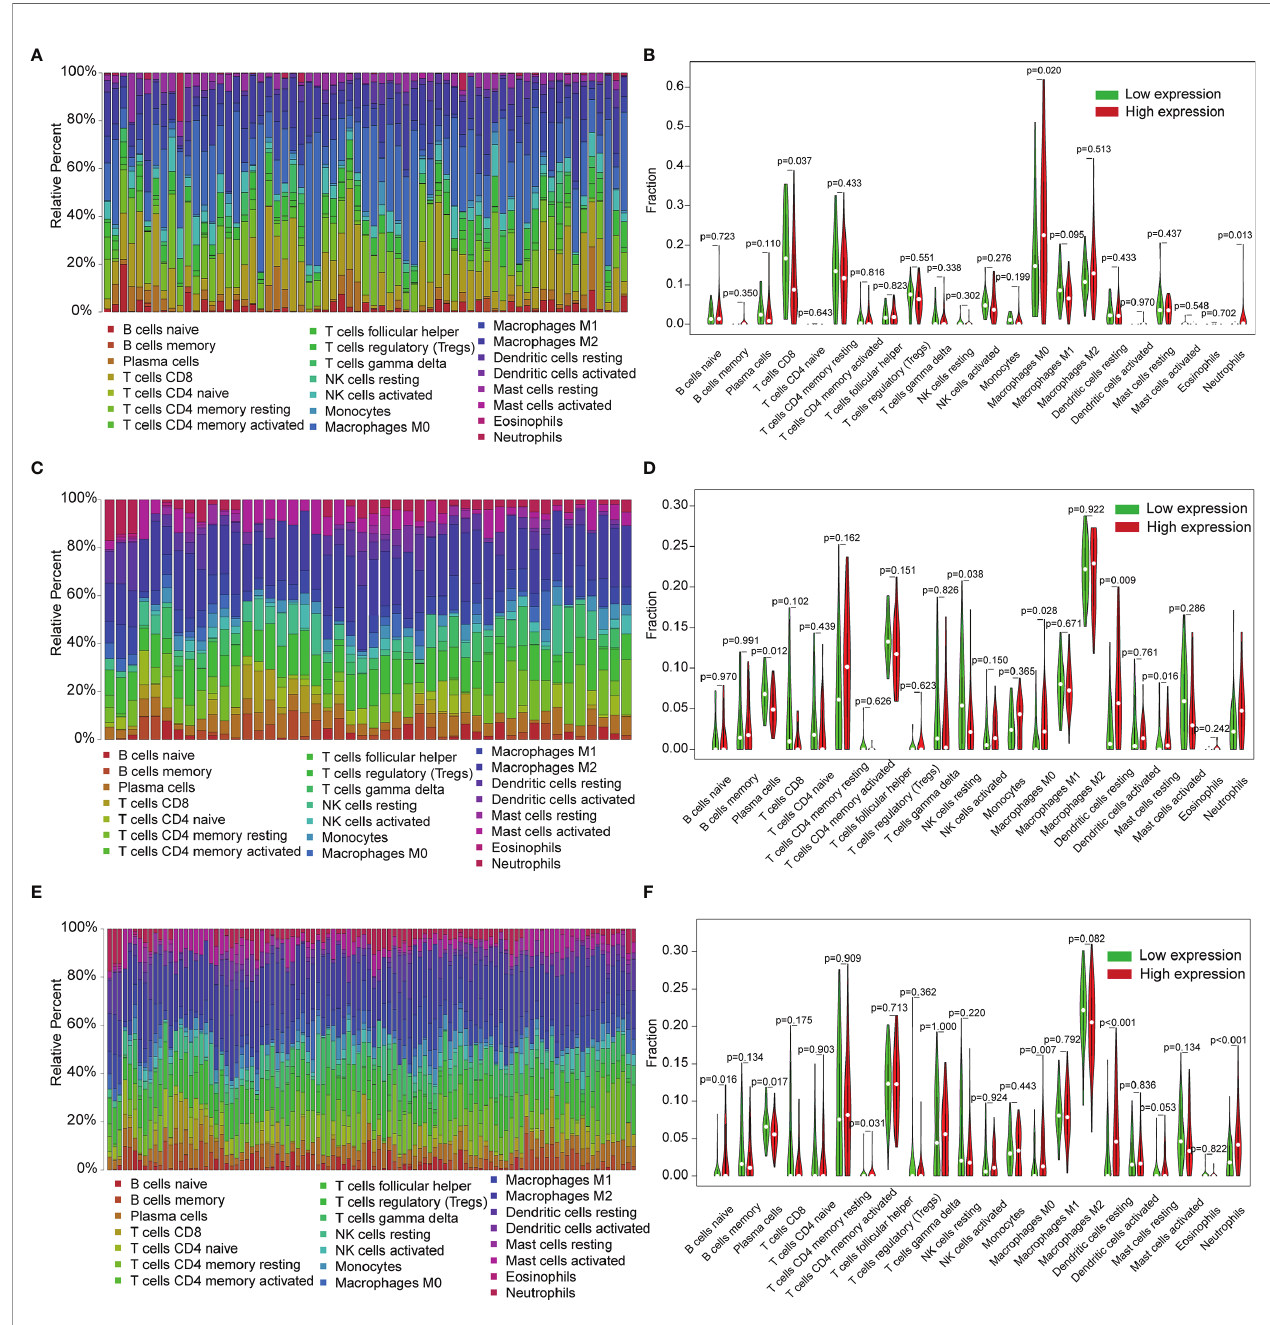
FIGURE 8 | Relationship of COMMD2 expression with 22 immune cell types in LIHC based on CIBERSORT. (A, C, E) Relative fractions of 22 immune cell types in the TCGA-LIHC cohort (A) , GSE55092 (C) and GSE107170 (E) . (B, D, F) Violin plots of the difference in 22 immune cell types between patients with high and low COMMD2 expression from the TCGA-LIHC cohort (B) , GSE55092 (D) and GSE107170 (F)